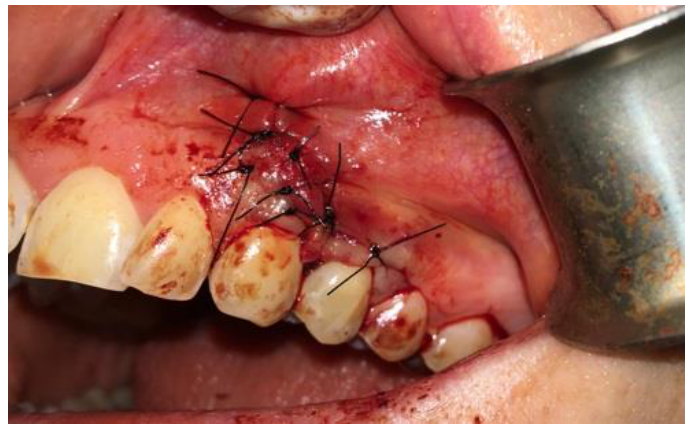
Figure 5. Intraoperative photograph with sutured collagen membrane onto xenograft bone with iPRF.